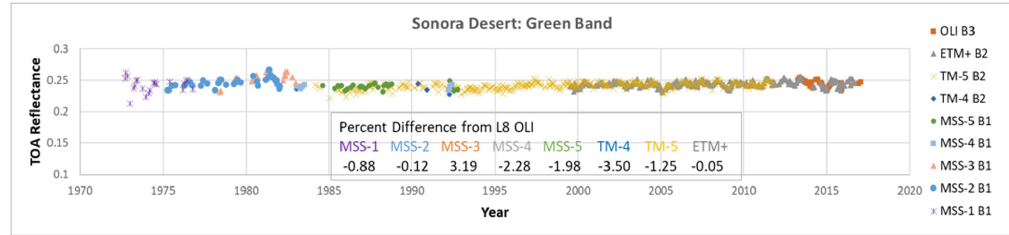
Figure 6. Observation of the Sonora Desert PICS over time for Landsat 1–8 after cross-calibration. Prior to calibration, di ff erences between sensors were as large as 15%, following calibration di ff erences are on the order of 3% or